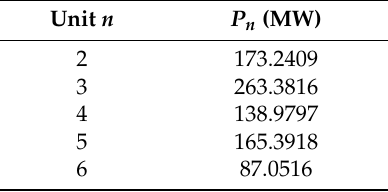
Table A1. The best decision variables for systems 1 found by the proposed method.